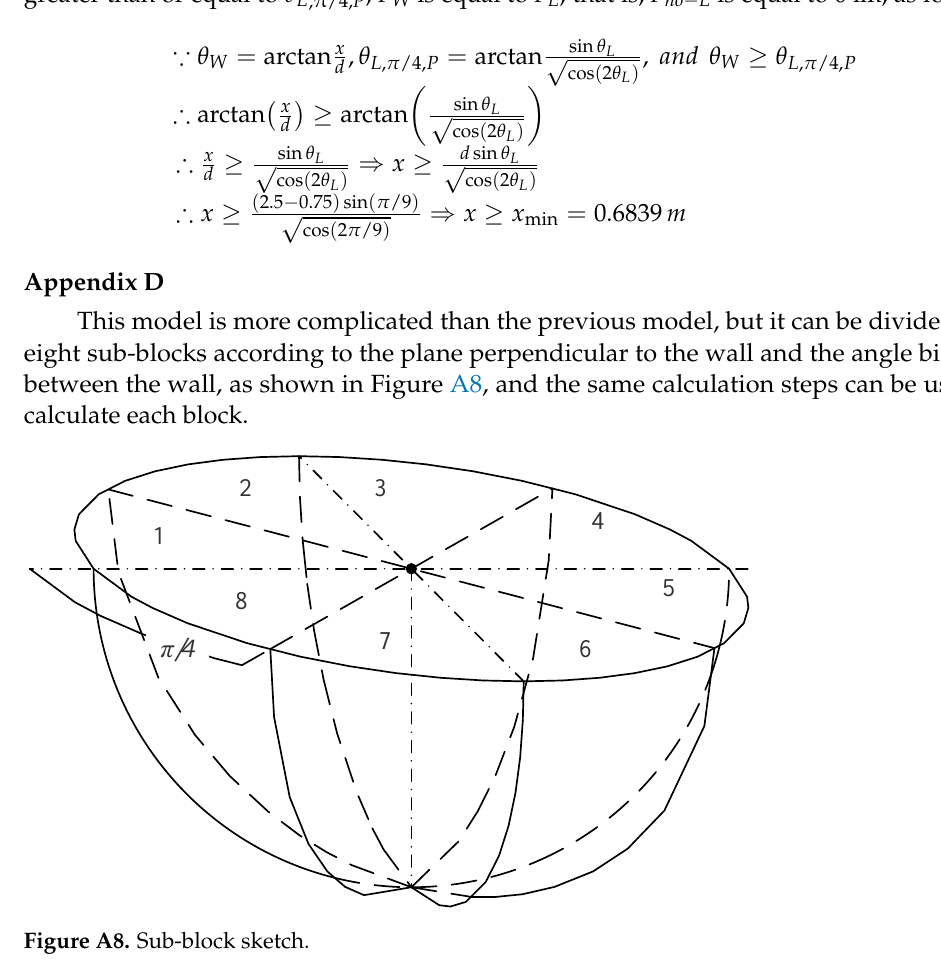
Figure A8. Sub-block